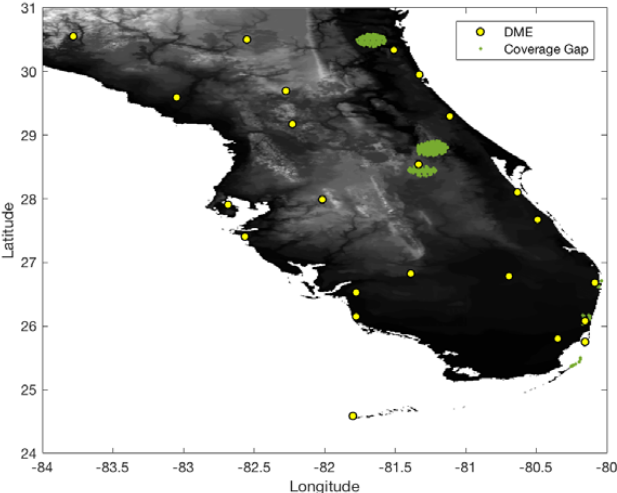
Figure 7. DME/DME positioning accuracy gaps of 1.0 nm with legacy DME and the current DME ground network.